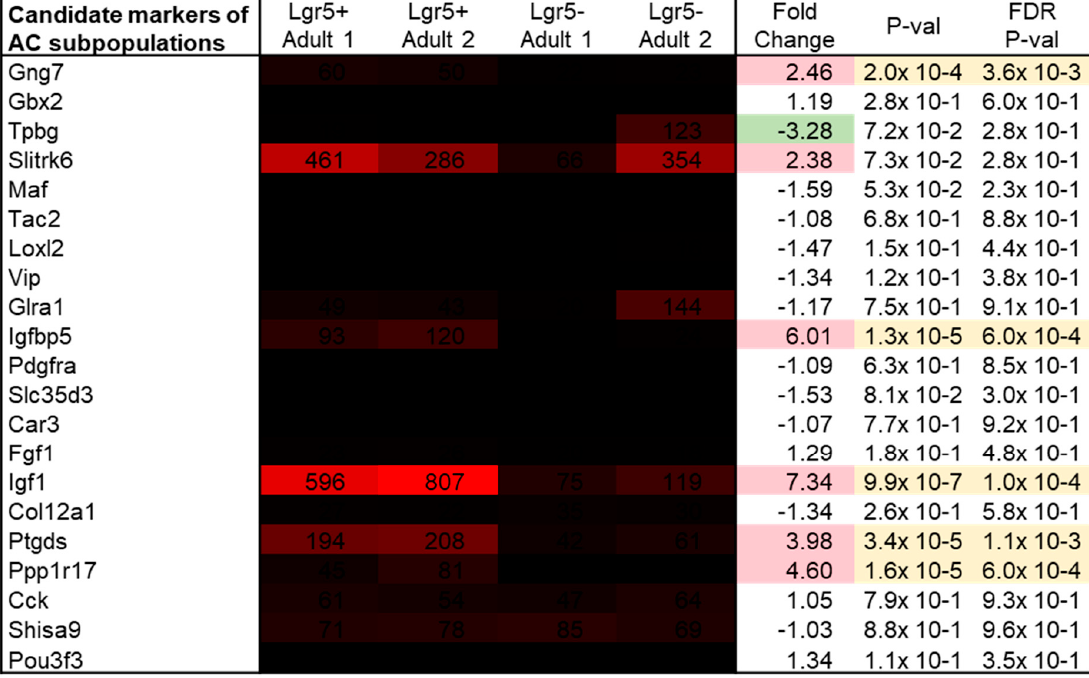
Figure 6. Gene expression levels and fold changes of candidate markers of amacrine cell subpopulations. Fold change shows expression of Slitrk6, Igf1 and Ptgds above the threshold of 100. Differentially expressed genes were defined by a fold change ≥ 2 or ≤ − 2, p -value < 0.05, and false discovery rate (FDR) < 0.05.